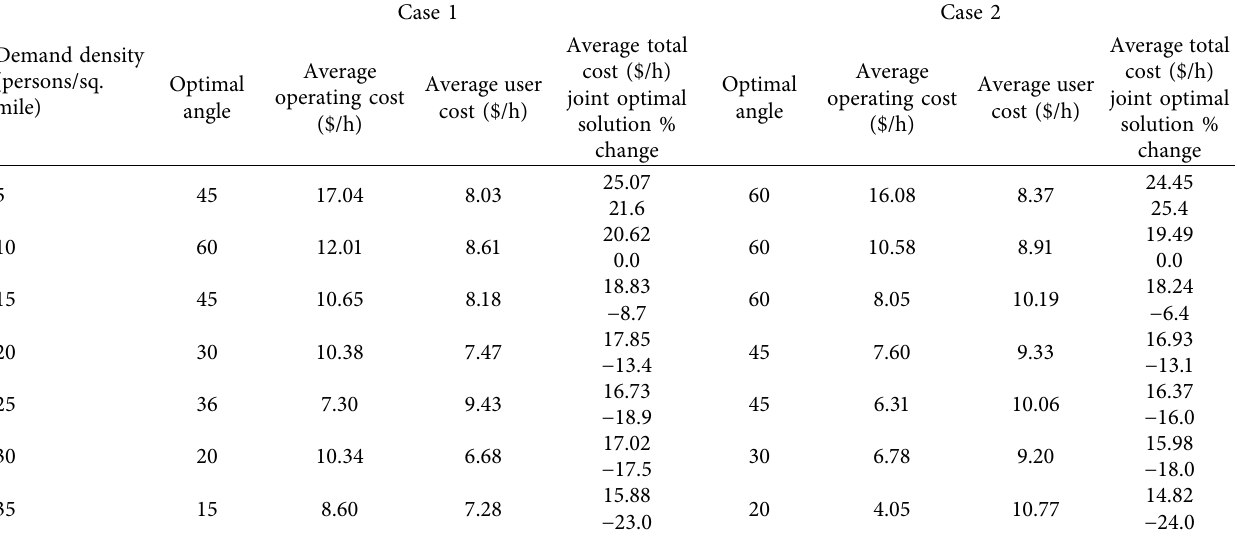
Table 3: Joint optimal solution for demand variations.